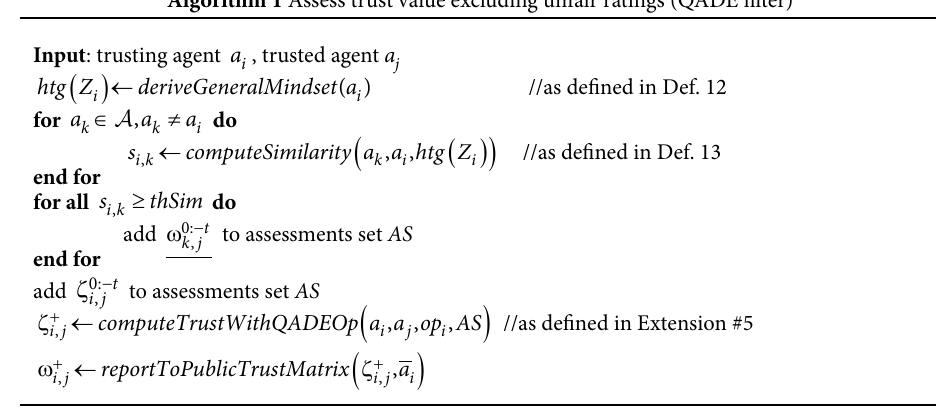
Table 2. QADE filtering algorithm (Extension #10) Algorithm 1 Assess trust value excluding unfair ratings (QADE